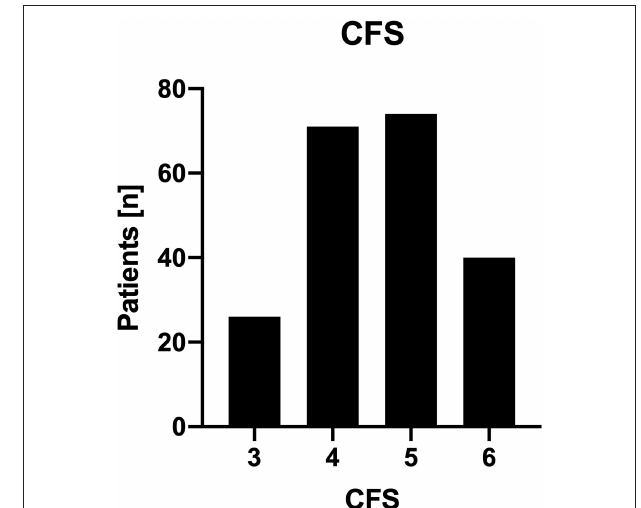
FIGURE 1 | Distribution of patient CFS. Histogram of clinical frailty score. This histogram demonstrates the distribution of patient CFS among patients undergoing surgery for VPS placement to treat